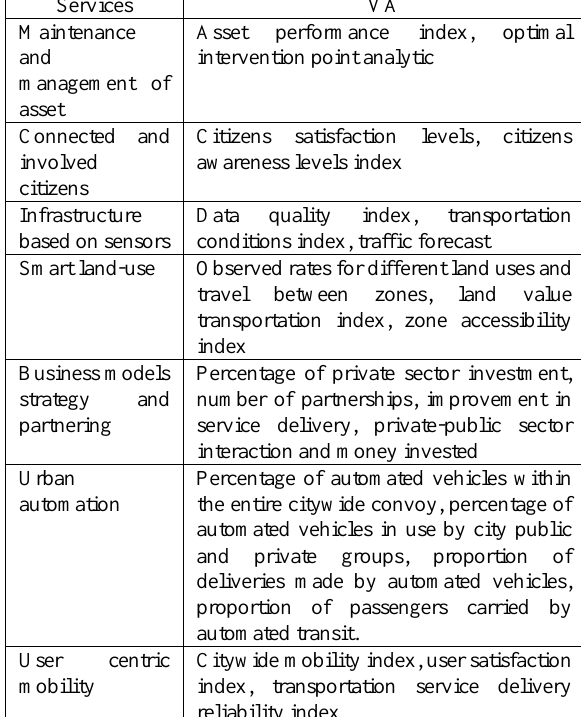
Table 3. Available services in the smart cities and